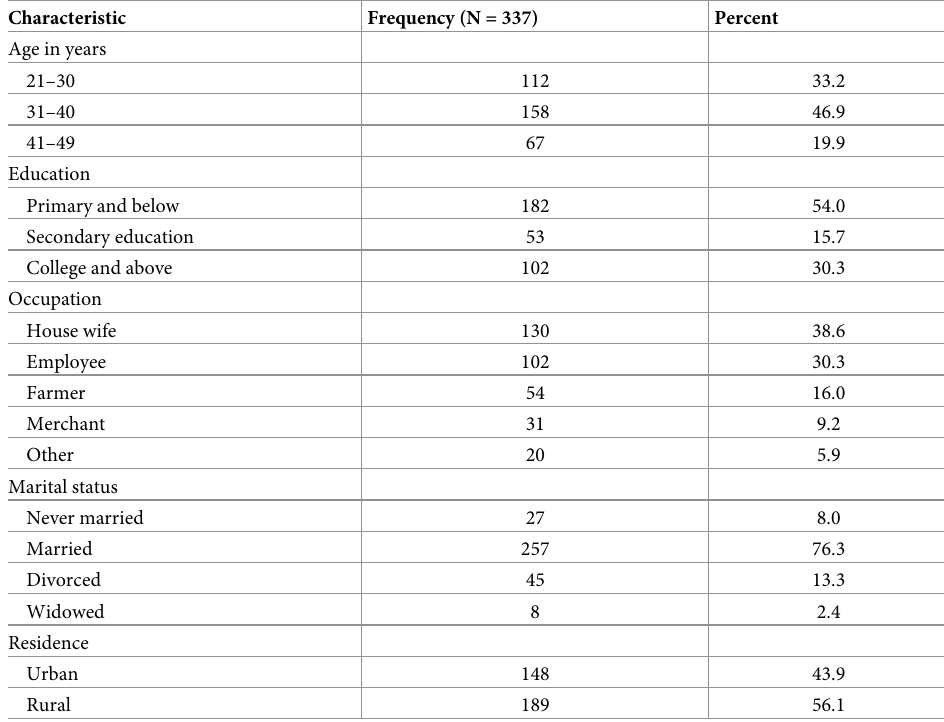
Table 1. Demographic characteristics of participant women (n = 337) aged 21–49 years, Amhara region, Ethiopia, 2019.